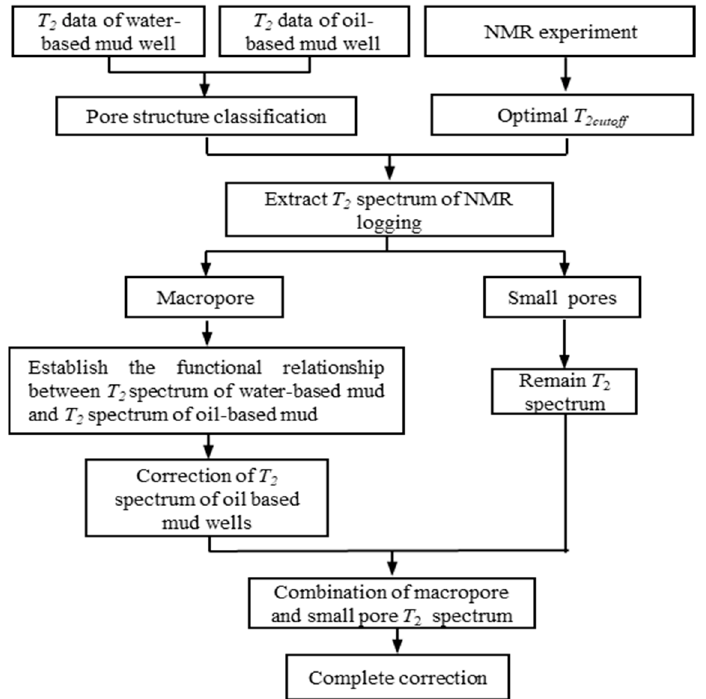
Figure 10. Workflow of the T 2 spectrum shape correction method for NMR logging under oil-based mud conditions.